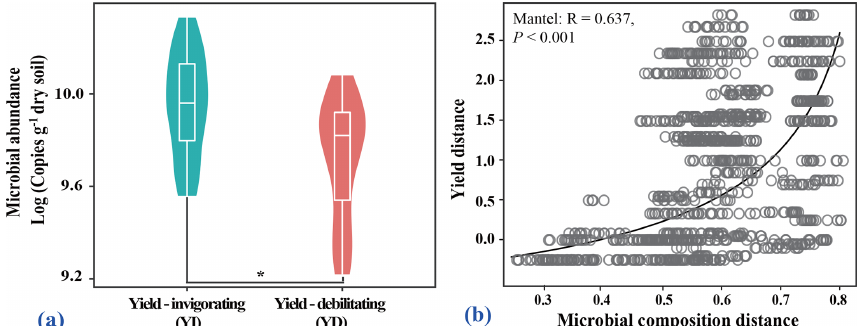
Figure 2. Quantitation of the abundance of bacteria population, and linkage of microbial composition to pear yield. (a) Violin plot showing the abundance of total bacteria for all selected orchards. The asterisk indicates a significant difference between yield-invigorating (YI) and yield-debilitating (YD) orchards based on Wilcoxon tests ( p < 0 . 05). (b) Correlation plot showing the relationship of microbial composition and yield based on Bray–Curtis distances calculated by the Mantel test.